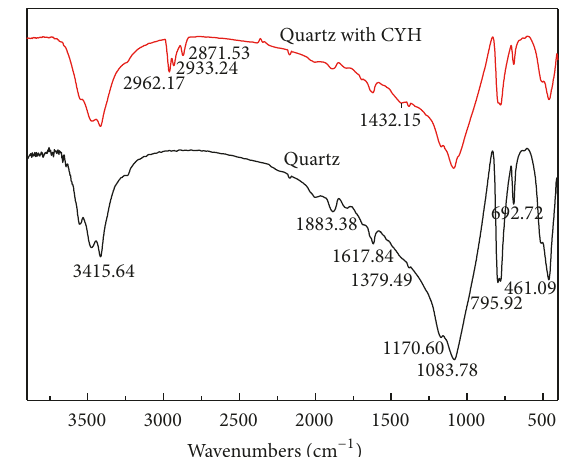
Figure 6: FTIR spectra of quartz before and after interaction with CYH.